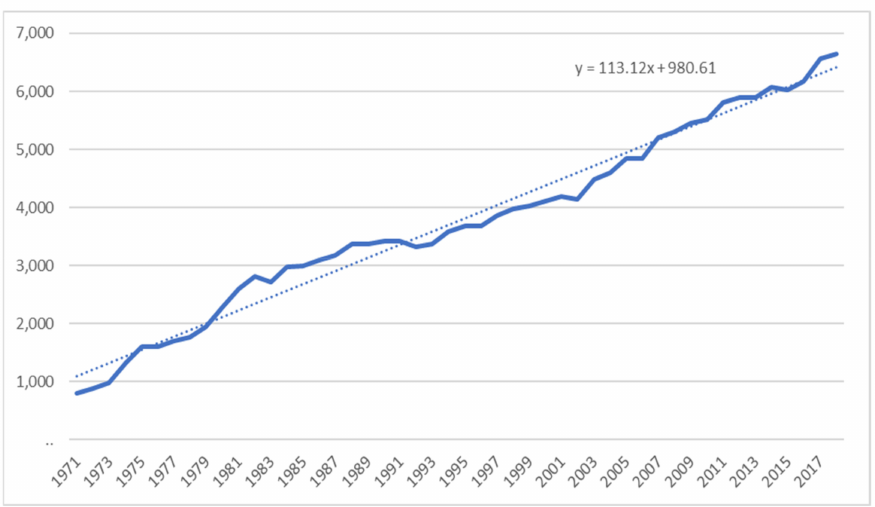
Figure 5. Canadian Farm Cash Receipts ( × CAD 1,000,000) from Dairying in Canada 1971 to 2018. Source: Canadian Dairy Information Center, 2019.